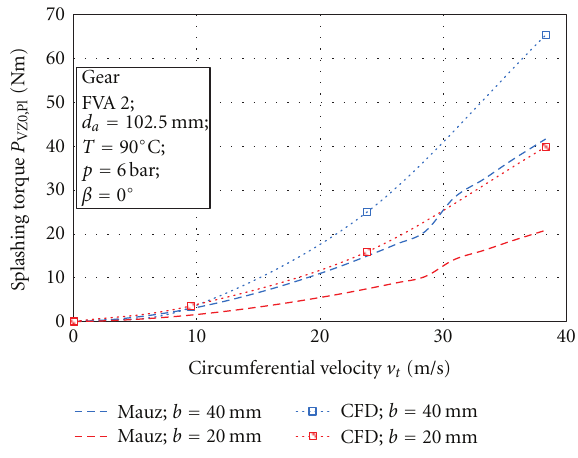
Figure 12: Results in terms of resistant torque versus circumferen- tial velocity—Influence of the face